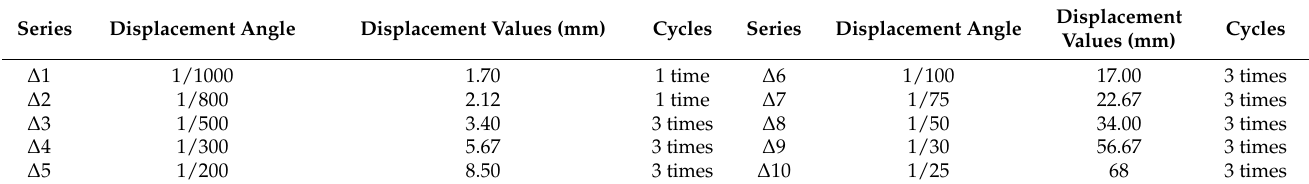
Figure 8. Horizontal loading system. Table 3. Loading value. Table 3. Loading value.